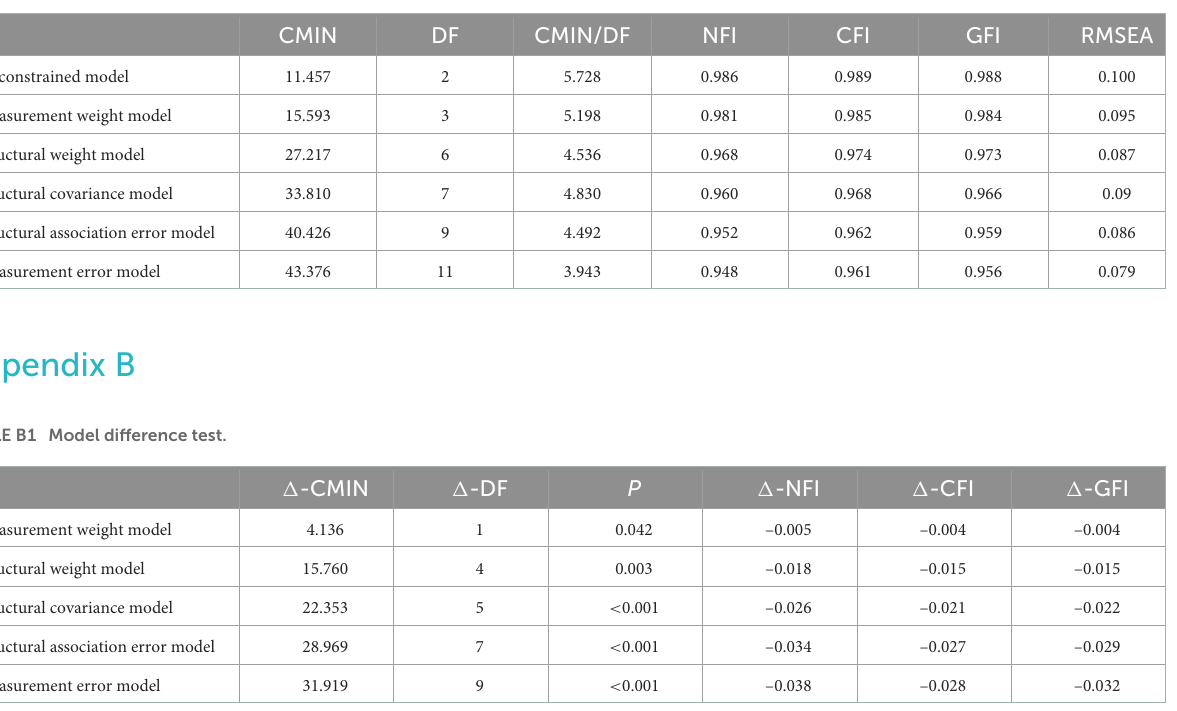
TABLE A1 The multiple group analysis.